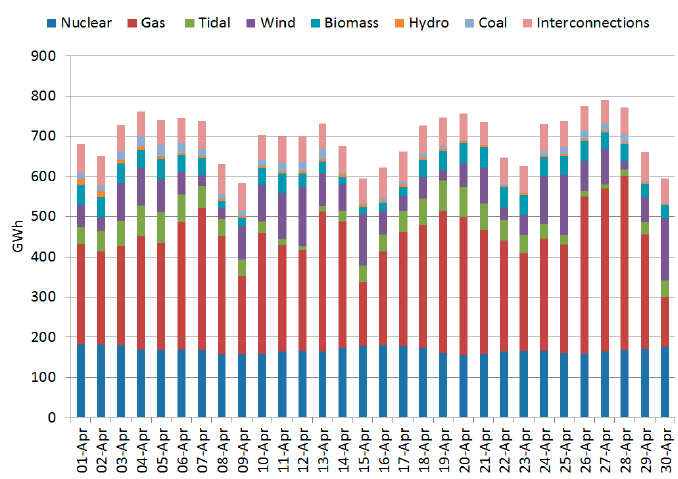
Figure 21. Modification of the energy generation pattern in the UK by source, taking into account tidal generation. It is assumed that all power generated by the tidal lagoons can be dispatched (no curtailment is applied).